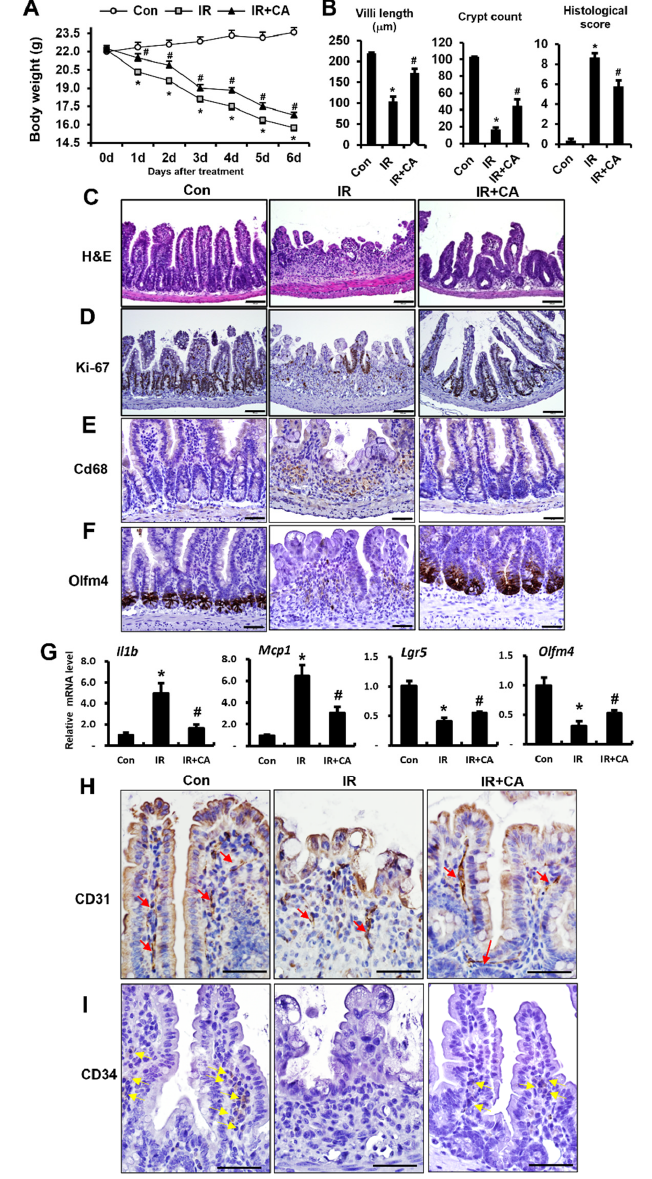
Figure 2. Centella asiatica alleviates radiation-induced enteritis in mouse model. ( A ) Body weights of control (Con), irradiated (IR), and Centella asiatica (CA)-treated irradiated mice (IR + CA). ( B ) The length of villi, crypts counting, and histological scoring in the small intestine were quantified. Histological scoring was assessed based on the degree of epithelial architecture maintenance, crypt disruption, vascular enlargement, and infiltration of inflammatory cells in the lamina propria of the ileum of Con, IR, and IR + CA mice groups (0 = none, 1 = mild, 2 = moderate, and 3 = high). ( C ) Hematoxylin and eosin (H&E) staining was performed using small intestine of Con, IR, and IR + CA groups. ( D ) Representative images of the small intestine stained with Ki-67 showing proliferation. Scale bars represent 100 µ m. Representative images of the small intestine stained with ( E ) Cd68 and ( F ) Olfm4. Scale bars represent 50 µ m. ( G ) qRT-PCR analysis demonstrating the mRNA levels of Il1b , Mcp1 , Lgr5 , and Olfm4 in small intestine of each group. Representative images of the small intestine stained with ( H ) CD31 showing the positive endothelial cells and ( I ) CD34 showing the positive endothelial progenitor cells. Red arrows indicate the CD31-positive endothelial cells. Yellow arrows indicate the CD34-positive endothelial progenitor cells. Scale bars represent 50 µ m. Data are presented as the mean ± standard error of the mean; n = 6 mice per group. * p < 0.05 compared to the Con group; # p < 0.05 compared to the IR group. All data represent at least two independent